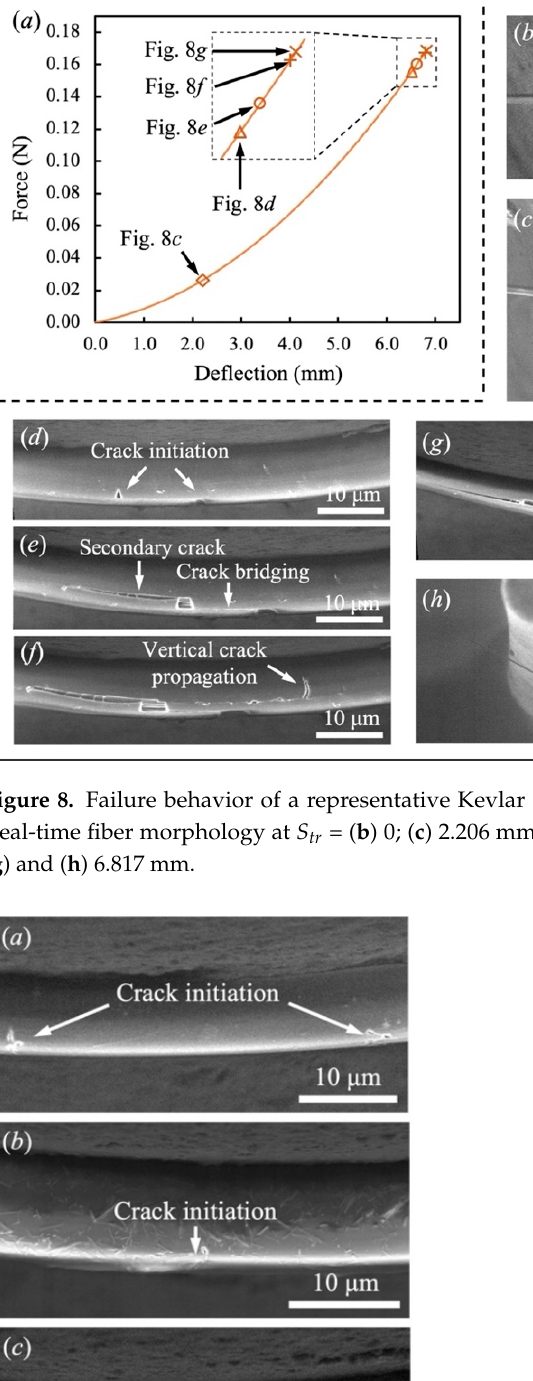
Figure 9. Crack initiation and propagation in other representative Kevlar KM2 Plus fiber speci- mens. ( a ) Two cracks initiated with a large interval; ( b ) One crack initiated during loading; ( c ) Crack propagation.